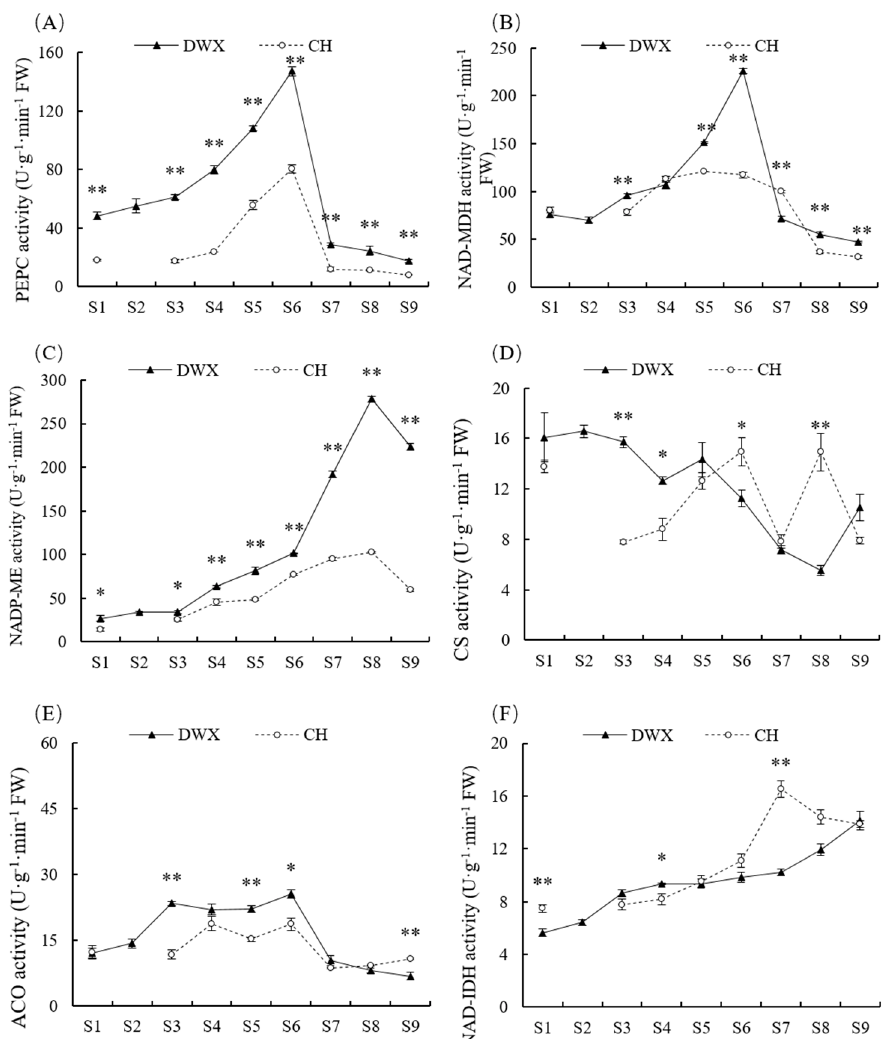
Figure 4. Dynamic changes of ( A ) phosphoenolpyruvate carboxykinase (PEPC), ( B ) NAD-malate dehydrogenase (NAD-MDH), ( C ) NAD-malic enzyme (NAD-ME), ( D ) citrate synthase (CS), ( E ) aconitase (ACO), ( F ) NADP-isocitrate dehydrogenase (NAD-IDH) enzyme activities at different stages during fruit development and ripening of Dawuxing and Chunhua loquats. The stages on the x-axis corresponded to those presented in Figure 1. The enzyme activities were expressed as units of activity per g fresh weight. The asterisks in the line charts indicate significant differences (*: p ≤ 0.05; **: p ≤ 0.01). Table 3. Correlation analysis of organic acids with related enzyme activities.